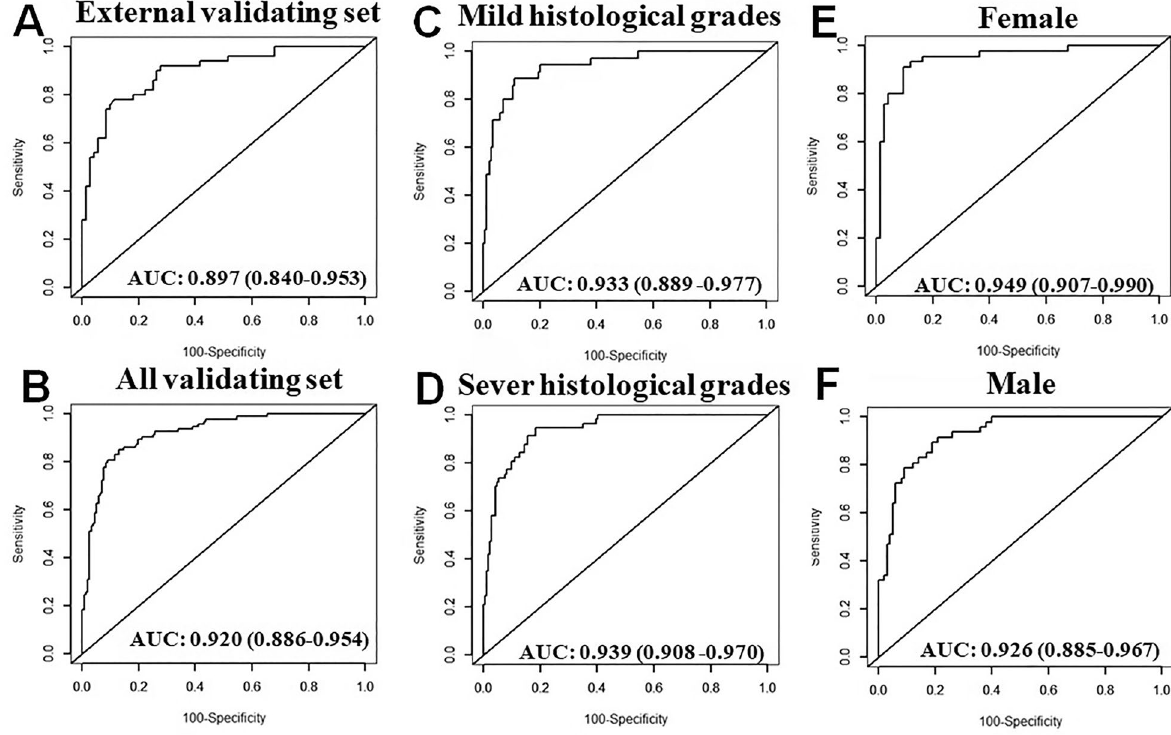
Figure 4. Receiver operating characteristic curve analysis of AIDi nomogram for predicting the risk of IgA vasculitis nephritis in different stratified sets. AUROC of the AIDi predicting the development of IgA vasculitis nephritis in external validating set (n = 122) ( A ) and in all validating set (internal and external validation, n = 250) ( B ); AUROC of AIDi predicting the risk of IgA vasculitis nephritis in the mild histological grades group (I and IIa, n = 35) ( C ) and the sever histological grades (IIb and above, n = 57) ( D ); AUROC of the AIDi predicting the risk of IgA vasculitis nephritis in females (n = 119) ( E ) and males (n = 147) ( F